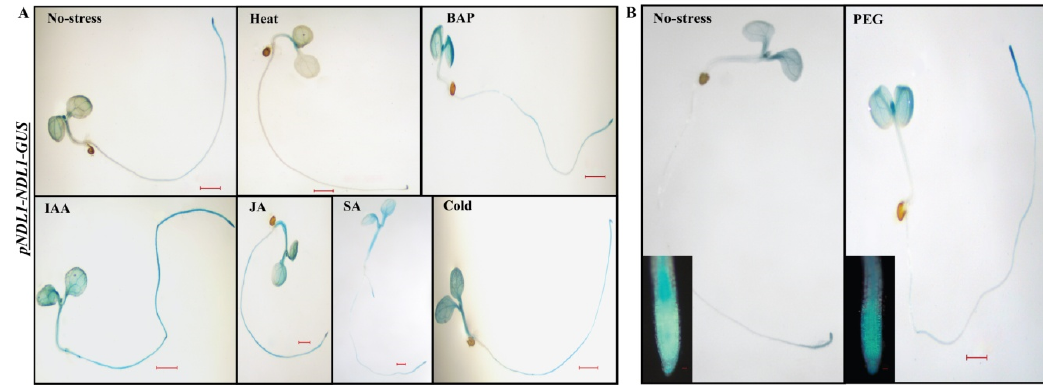
Figure 5. In vivo histochemical GUS activity for NDL1 in wild type background in response to di ff erent abiotic stresses and hormones: ( A ). Histochemical analysis of GUS activity for NDL1 in wild type background in response to di ff erent abiotic stress and hormones. Changes in intensity of GUS staining were detected with Heat, Cold, IA, JA, SA and BAP. GUS staining was done in seedlings that were six days old and 24 h of stress treatment followed. ( B ) Histochemical GUS staining of 6-D-old pNDL1-NDL1-GUS seedlings in wild type Col-0 background. Increased levels of GUS staining intensity detected with PEG at root tip (inset). Result shown is representative of three independent biological replicates ( n ≥ 10 in each experiment). Scale Bar = 0.2 μM for seedlings and 0.02 μM for inset RAM.